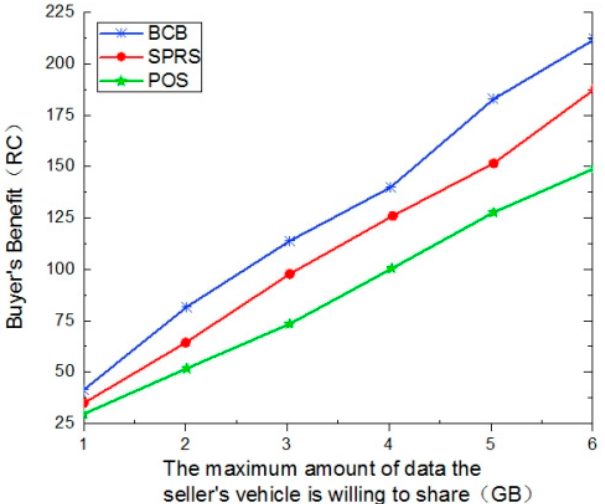
Figure 4. The impact of the most data provided by vehicle to the buyer’s benefit.